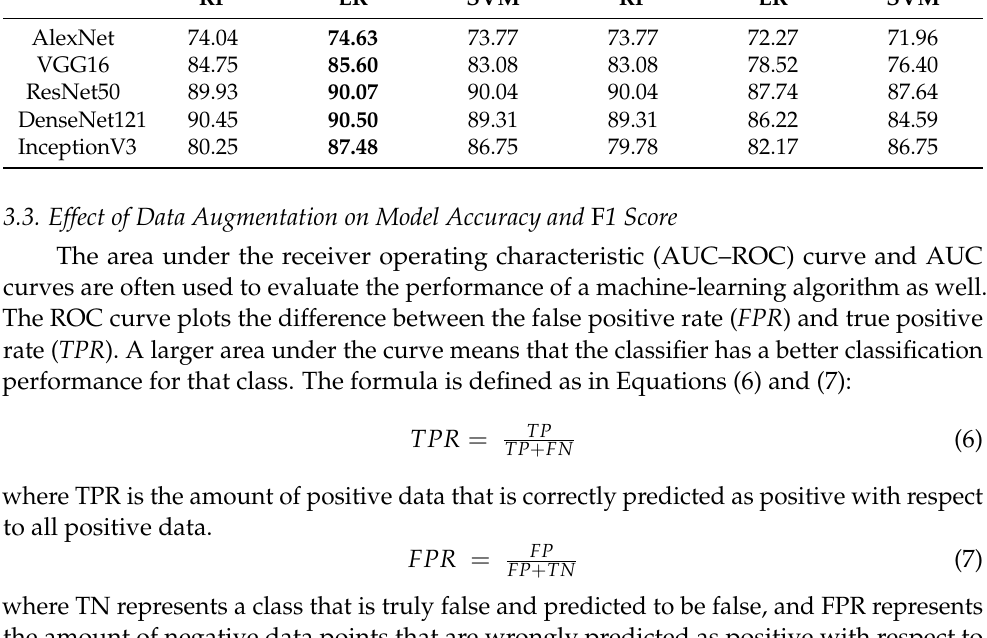
Table 4. F 1 scores for the model ensemble with and without data augmentation.